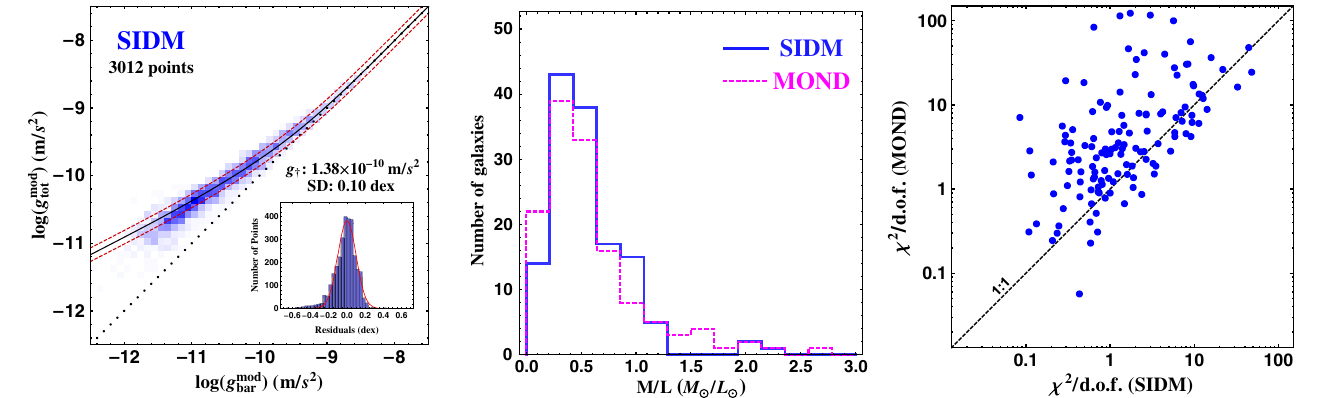
FIG. 2. Left panel: The radial acceleration relation from the SIDM fits, where g mod The black solid line is the best fit to Eq. (2); the two red dashed curves correspond to the 1 σ deviation from this fit. The black dotted line is the one-to-one reference line. Insets: Corresponding histograms of residuals after subtracting the fit function with the best-fitting scale parameter g † ¼ 1 . 38 × 10 − 10 m = s 2 , together with the Gaussian fits to the residuals, which have 1 σ widths of 0.10 dex. Middle panel: distributions for the SIDM and MOND fits. Right panel: Distribution of χ 2 = d : o : f : values for individual galaxies from the Inferred ϒ ⋆ ; disk SIDM and MOND